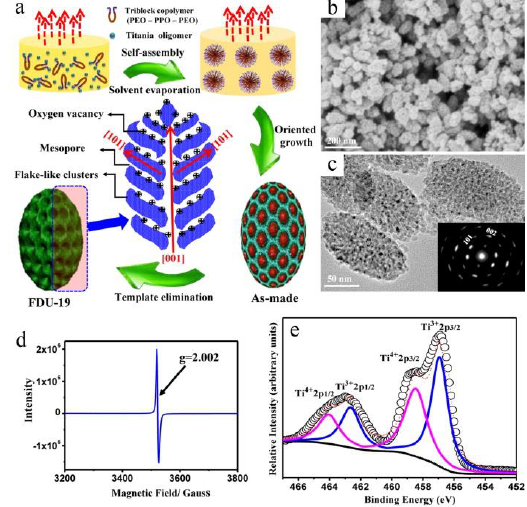
Figure 13. ( a ) Schematic illustration of the growth process of Ti 3+ self-doped olive-shaped mesoporous anatase TiO 2 mesocrystals through evaporation-driven oriented assembly process; ( b ) SEM image, ( c ) TEM image, ( d ) EPR spectra, and ( e ) Ti2p XPS core-level spectra of Ti 3+ self-doped olive-shaped mesoporous anatase TiO 2 mesocrystals. The inset in ( c ) is the SAED pattern of an individual mesocrystal. Reprinted with permission from [65]. Copyright American Chemical Society, 2015.